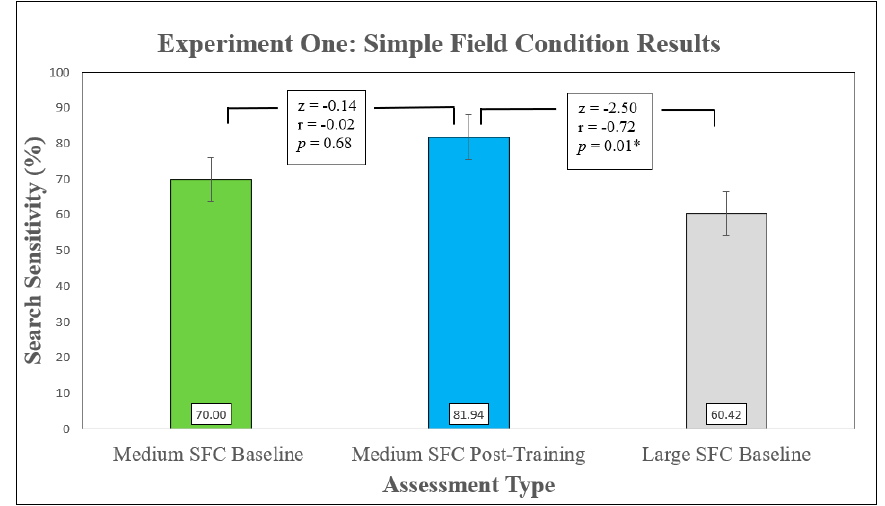
Figure 4. Group search sensitivity over the three different Simple Field Condition (SFC) search assessments of Experiment 1 are presented in chronological order: Medium SFC baseline (N = 10), medium SFC searches after 12 weeks of training (N = 12) and large SFC baseline searches (N = 12). Results of Wilcoxon Signed Rank Tests between each assessment are also presented. ‘*’ Indicates statistical significance ( p ≤ 0.05). Error bars represent standard error.